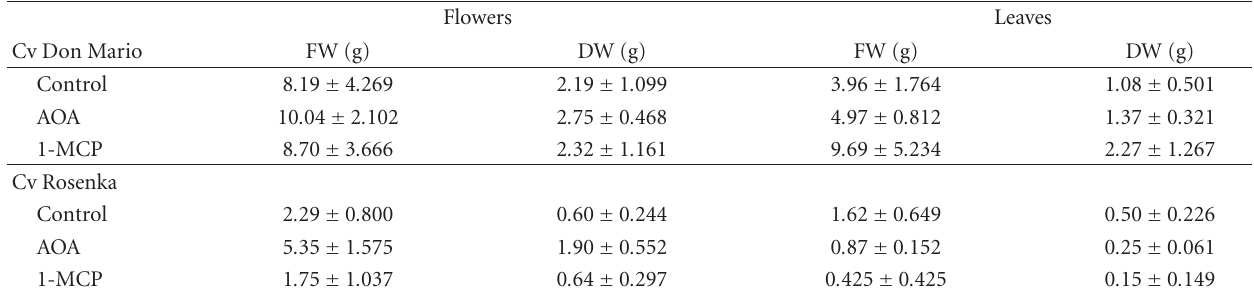
Table 1: Flower and leaves lost after seven days storage from two Bougainvillea cultivars. Values are means with standard errors ( n = 5). Flowers Leaves Cv Don Mario